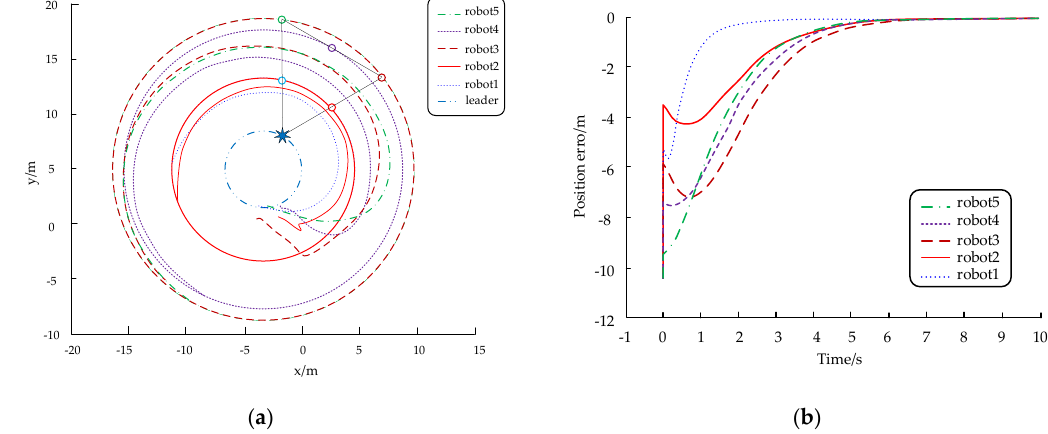
Figure 9. ( a ) Trajectory of triangular formation by GCF; ( b ) Position error of triangular formation.